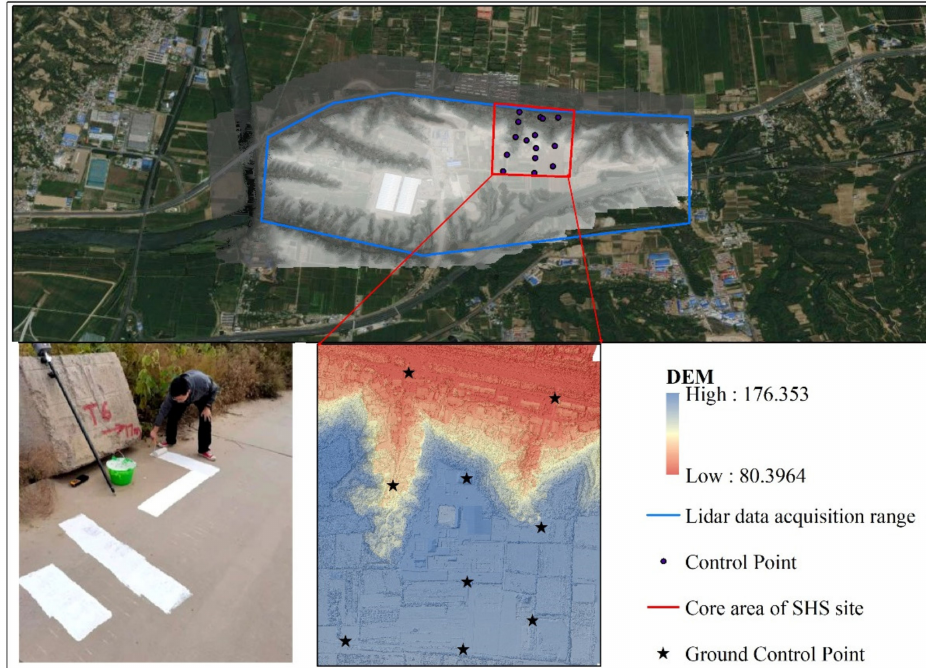
Figure 5. Data processing for the SHS